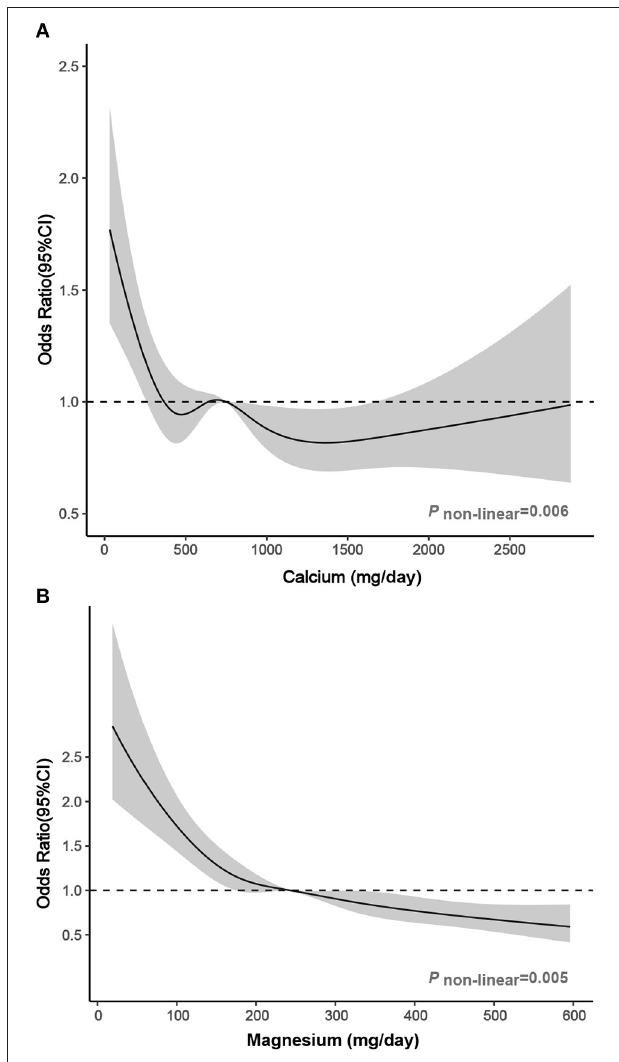
FIGURE 2 | Association between dietary (A) calcium and (B) magnesium intake and headache in RCS. The model was adjusted for age, sex, race/ethnicity, smoking, drinking, marital, education level, BMI, energy intake, protein intake, carbohydrate intake, calcium supplement, magnesium supplement, vitamin D supplement, hypertension, diabetes, stroke, coronary heart disease, C reactive protein, and total cholesterol. Solid line, OR; shade, 95%